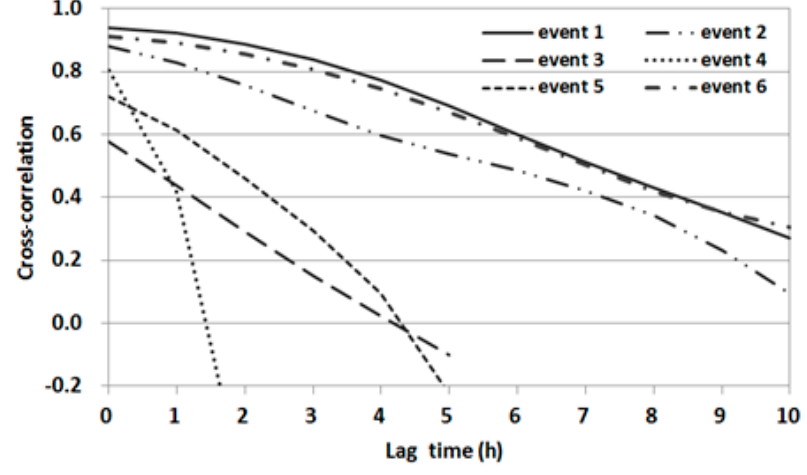
Figure 7. Cross-correlation of water level series between Hangangdaegyo (HG) and OG.